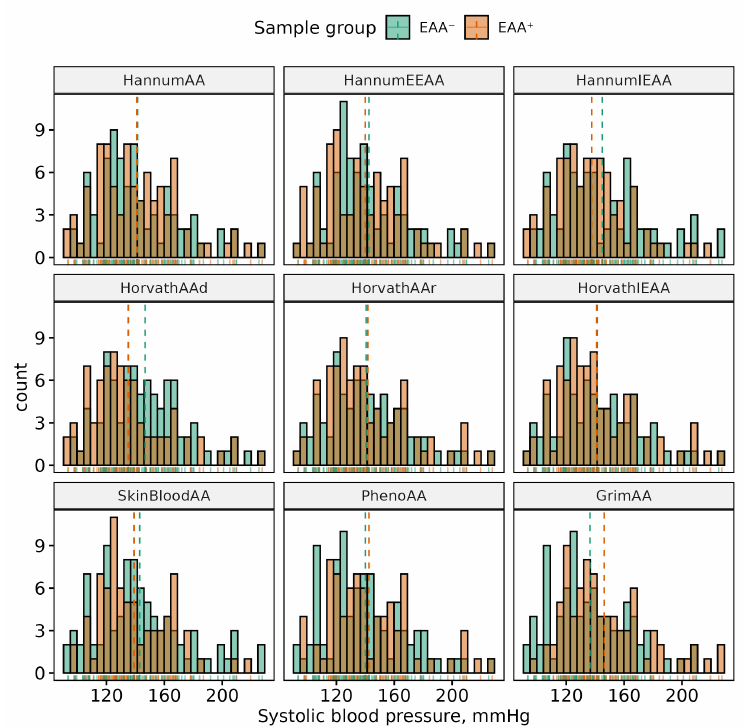
Figure A12. Histograms of distributions of SBP levels in females in EAA + and EAA − groups. Dashed lines correspond to the group